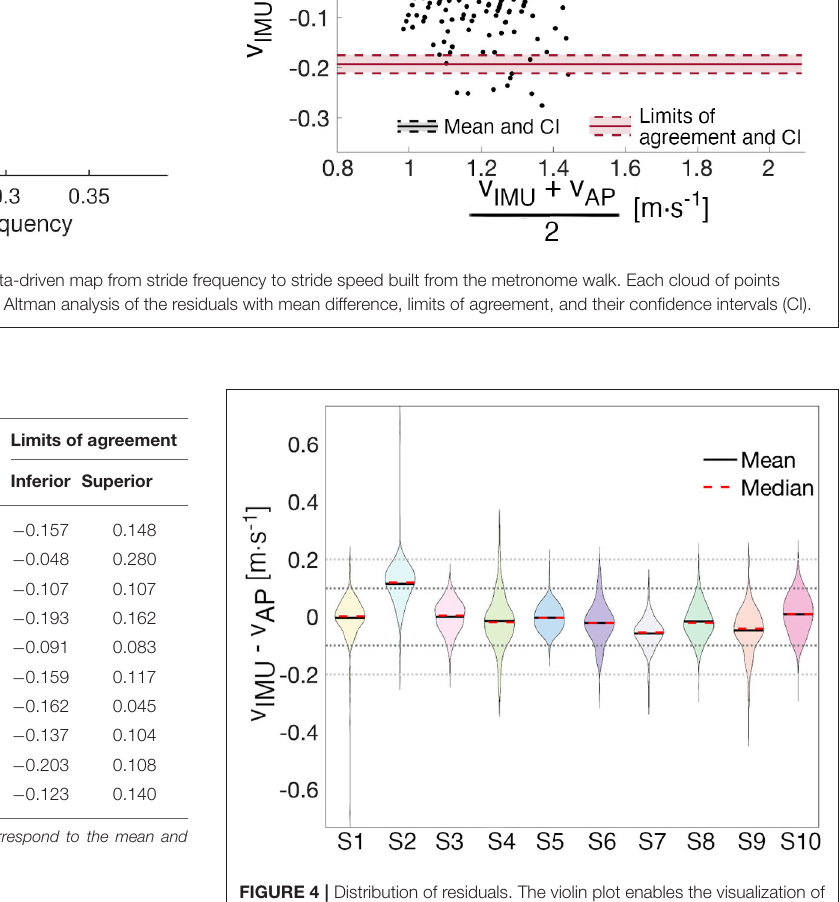
FIGURE 4 | Distribution of residuals. The violin plot enables the visualization of the distribution of the error for each subject with ± 0.1 m · s − 1 (black-dotted line) and ± 0.2 m · s − 1 (gray-dotted line) bands. Each shaded area represents the shape of the distribution of residuals for a particular